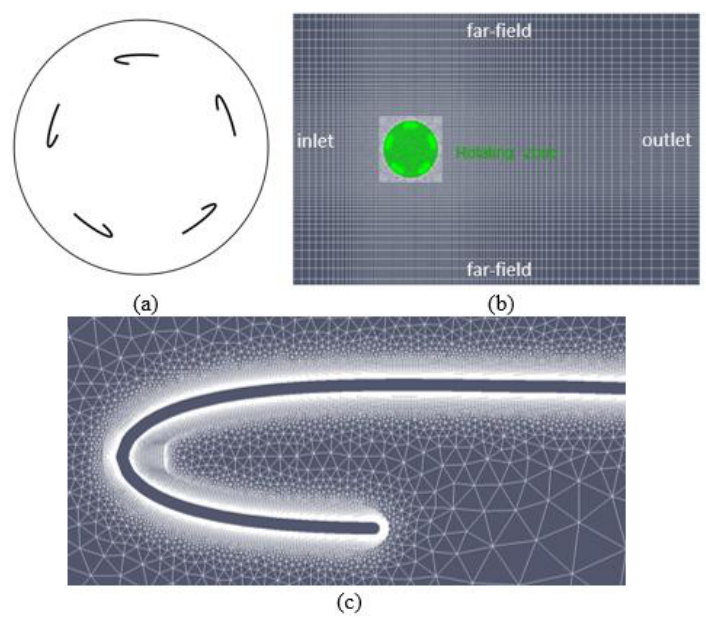
Figure 2. ( a ) Schematic of the blades. ( b ) The computational domain. The rotating zone of the computational domain is shown in green. The stationary zone is shown in grey. ( c ) The grid near the blade.